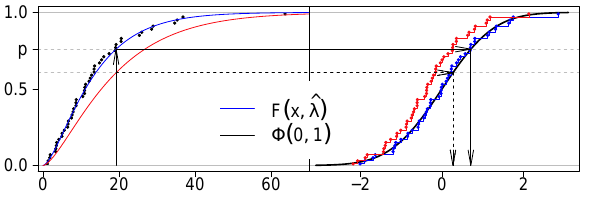
Fig. 1. Conceptual diagram illustrating the SPI calculation of ar- tificial data (black dots) with the estimated distribution ( F(x ; ˆ λ) , blue line, left) and another distribution given by the red line. The outcome is two different SPI time series, represented through their empirical distribution functions (blue and red lines, right).